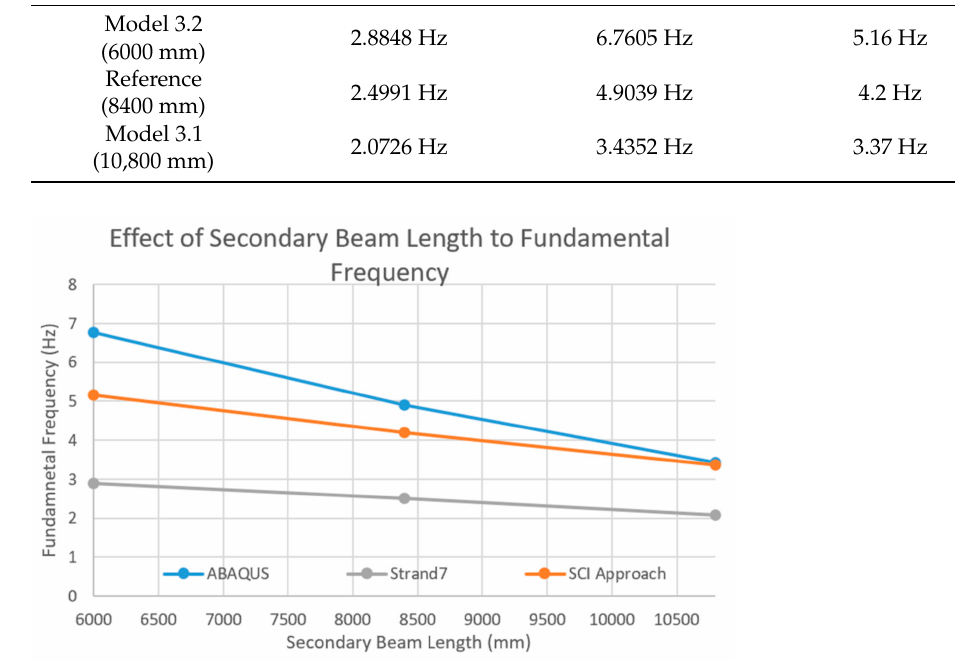
Figure 12. Comparison of the calculated Fundamental Frequency and the length of the secondary